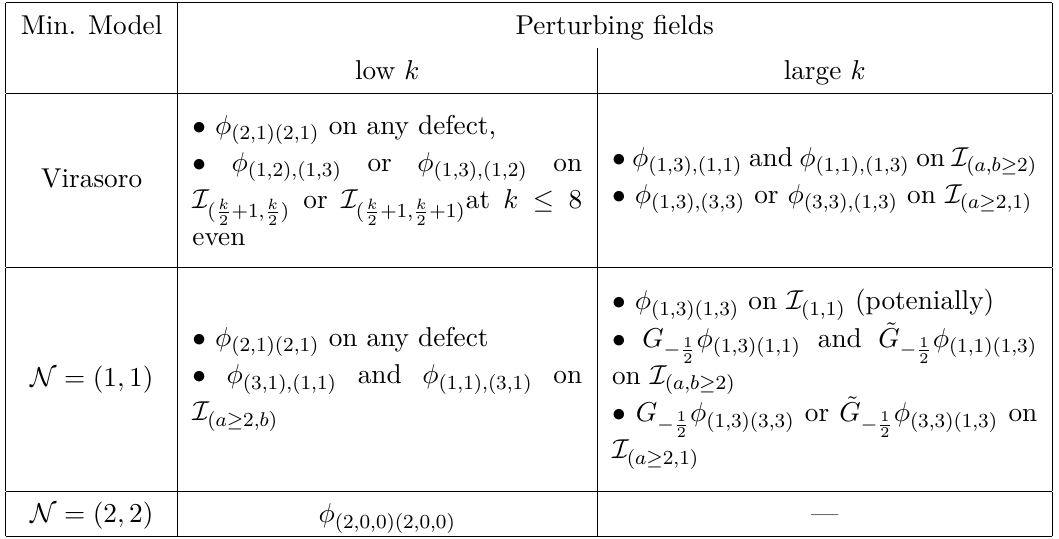
Table 1 . Defect fields in Minimal Models that lead to short flows on the respective topolo- gical